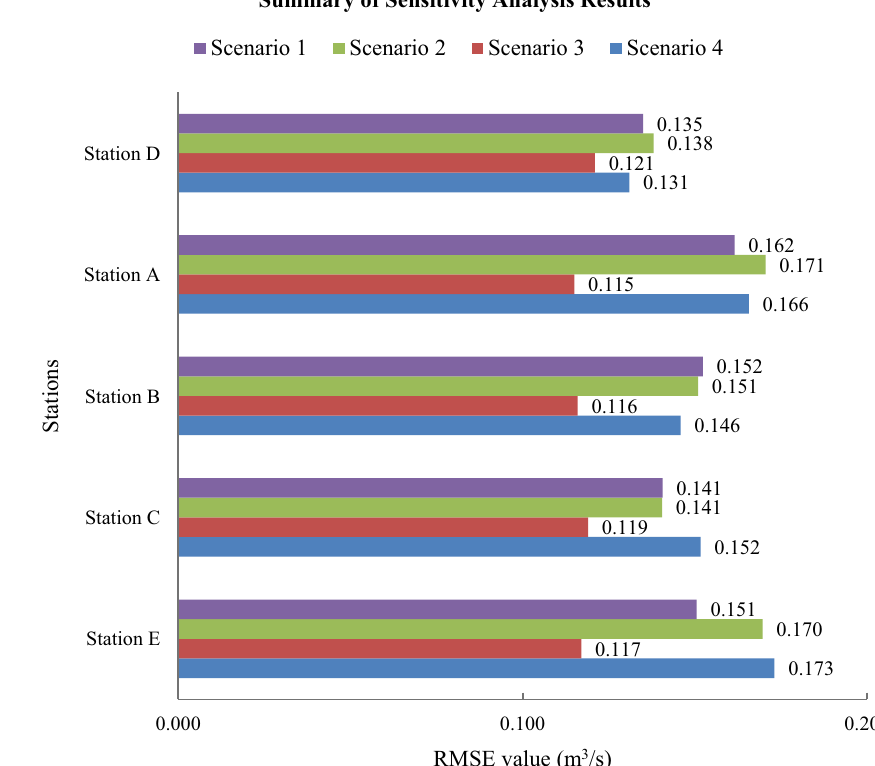
forecasting are best represented graphically, as shown in Fig. 6.